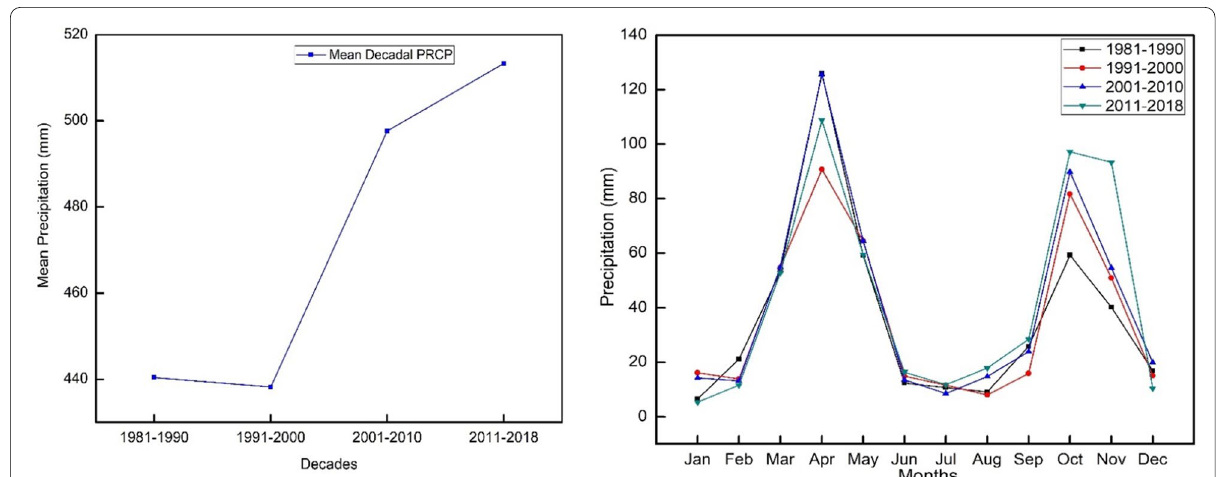
Fig. 12 Mean decadal rainfall distribution in semi-arid Borana